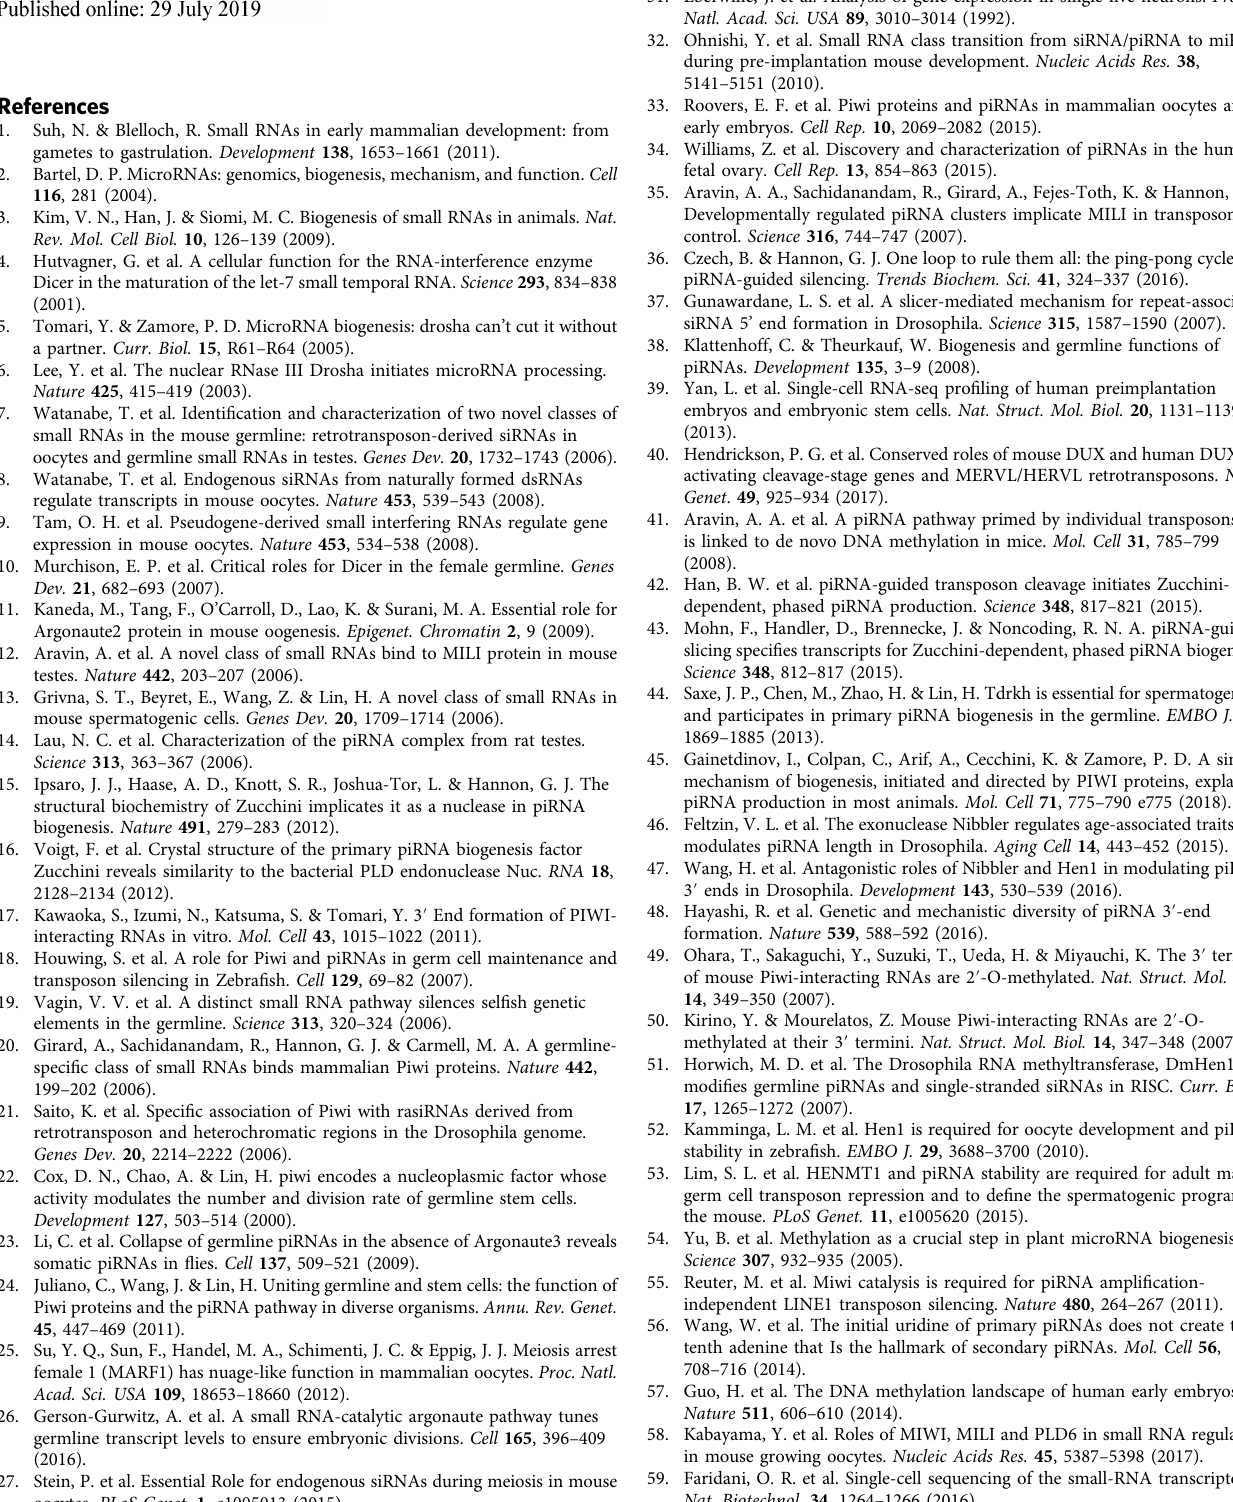
fi le. The deep sequencing data have been deposited in the National Center for Biotechnology Information Gene Expression Omnibus under accession number GSE95218. All data including the genomic distribution of small RNAs (WIG or Bed fi le), the os-piRNA complementary pairs with ping-pong signature, and the expression small RNAs derived from sn/snoRNAs, rRNAs and tRNAs is available from the corresponding author upon reasonable